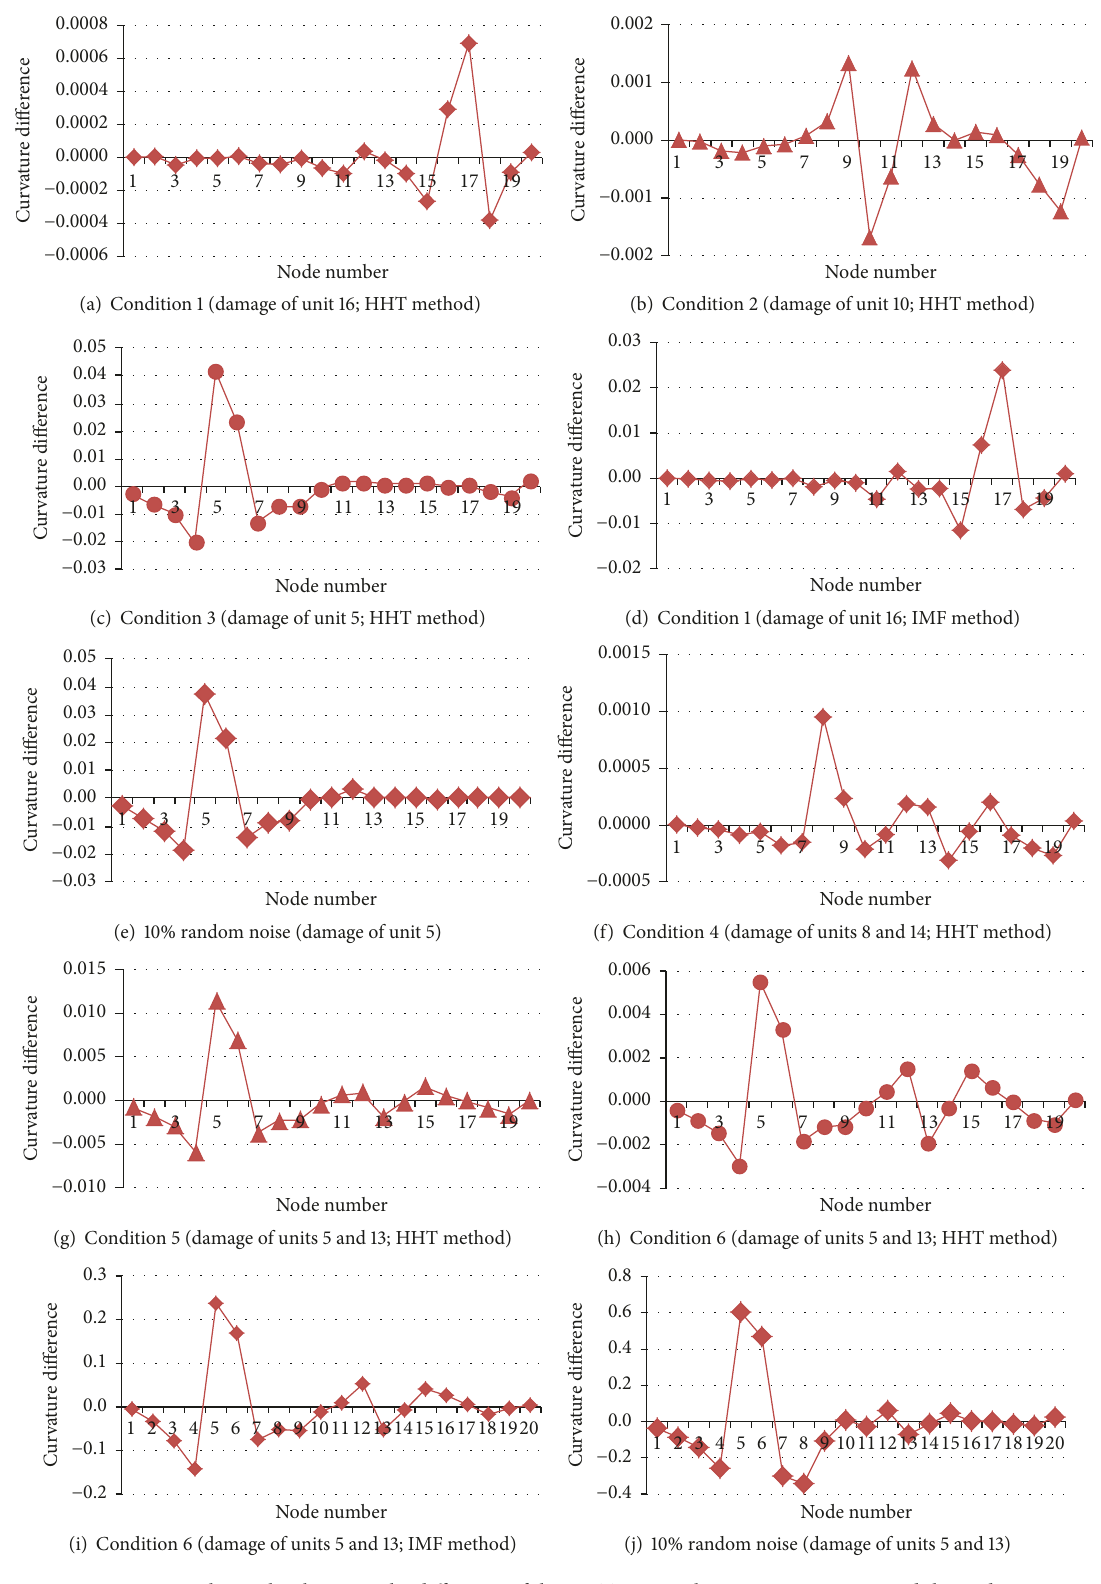
Figure 5: Relationship between the difference of the HHT marginal spectrum curvature and the